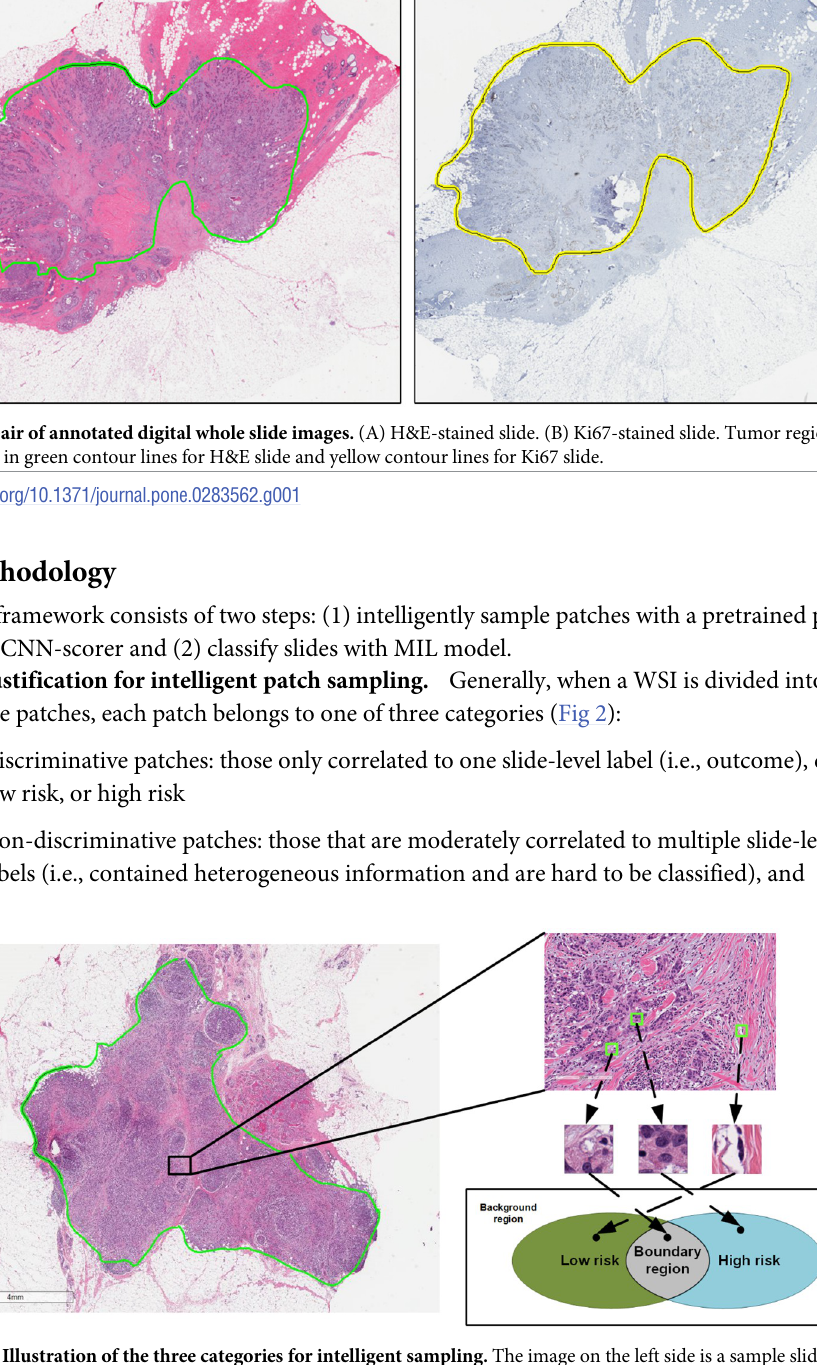
Fig 2. Illustration of the three categories for intelligent sampling. The image on the left side is a sample slide of our dataset where the tumor region is annotated in green line. Three example patches from an example region (shown as a black rectangle and magnified on the right side) are cropped from this example region (shown in green squares) and belong to different sections of the Venn diagram in the bottom. This Venn diagram demonstrated different implicit categories of patches of the WSI. The discriminative patches in green and blue section of the diagram are patches we want to sample for better slide-level classification.